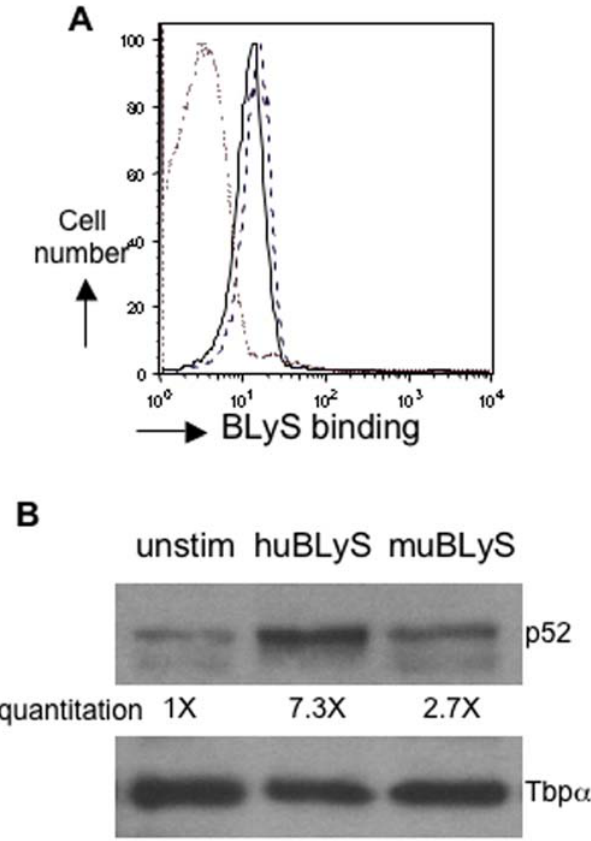
Figure 3. Nuclear localization of NF- k B p52. Purified CD19 + human B cells were A.) incubated with 100 ng/10 6 cells of FLAG-huBLyS or FLAG-muBLyS followed by biotinylated anti-FLAG and strep-avidin PerCP on the day of isolation prior to FACS analysis. Control stain with anti-FLAG and PerCP (dash/dot line); huBLyS (solid line) and muBLyS (dark dashed line) B.) B cells were cultured unstimulated or with 100 ng/ ml of human or murine BLyS for 48 hours. Cells were harvested, nuclear extracts prepared and Western blots prepared following protein separation on a 4–12% SDS gel. Blots were probed with anti-p52 antibody then stripped and reprobed with anti-TATAbp a antibody. Blots were developed by ECL. Data representative of 3 separate expts.